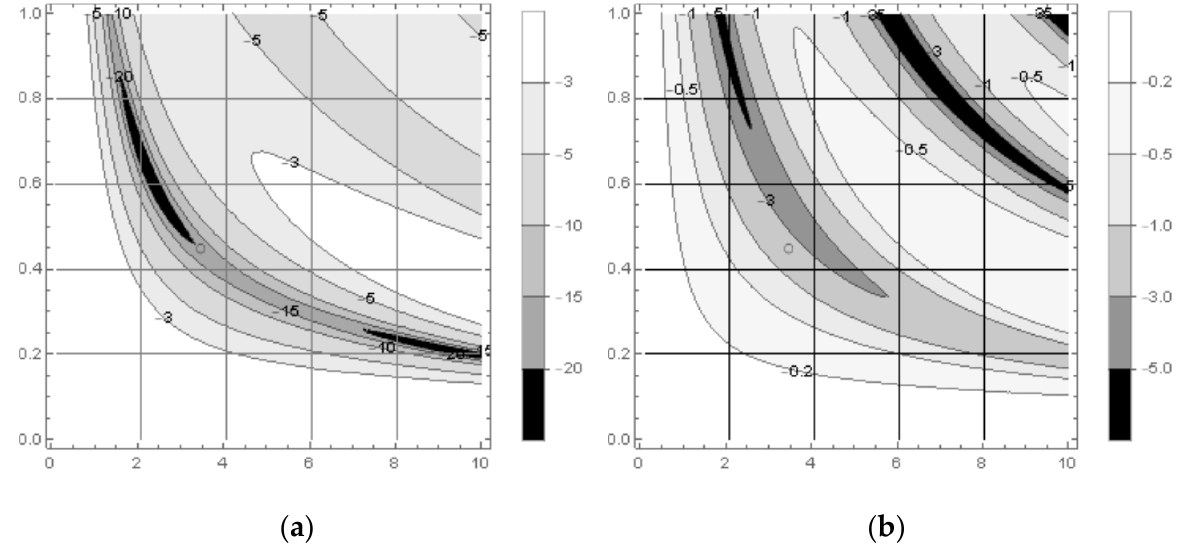
Figure 6. Contour maps for reflection coefficient (dB) of a shorted layer as a function of frequency and layer thickness ( x and y axis correspondingly) calculated for 0 ° С ( a ) and 20 ° С ( b ). The reflectivity control range of the composite under study is close to that of the composites with permeable microwires [4], while the transparency tuneability is lower (Figure 7a). The reason is that the temperature increase causes the simultaneous decrease of both real and imaginary permeability parts. The layer loss Exp decreases with temperature increase, but the layer specific impedance Re as well, thus increasing the reflection coefficient from the layer in a free space and decreas- ing the total effect on the transmission coefficient. Therefore the transparency variation range due to permeability control is in principle lower than the range due to permittivity control